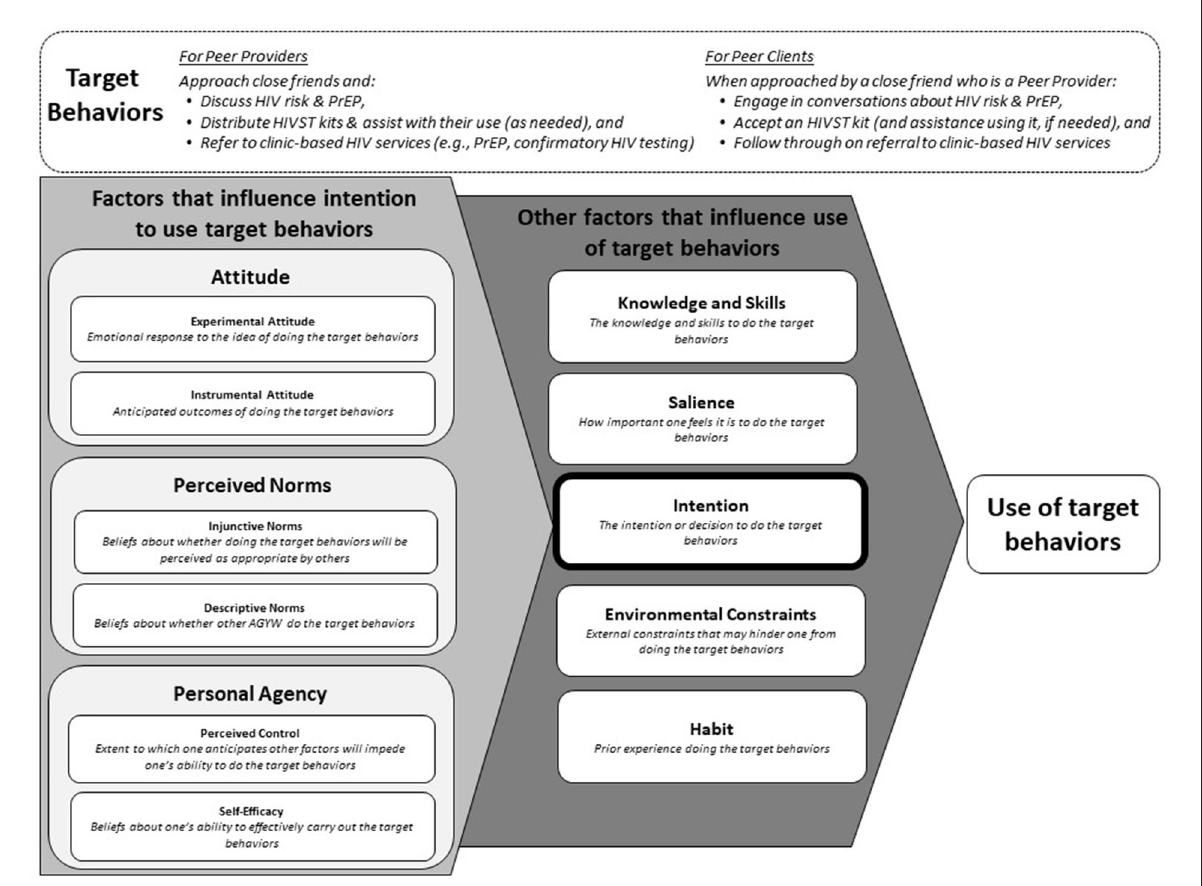
FIGURE1 Modified Integrated Behavior Model showing factors hypothesized to influence whether PrEP-experienced and PrEP-naïve AGYW perform the target behaviors of a peer provider or peer client, respectively, within the proposed